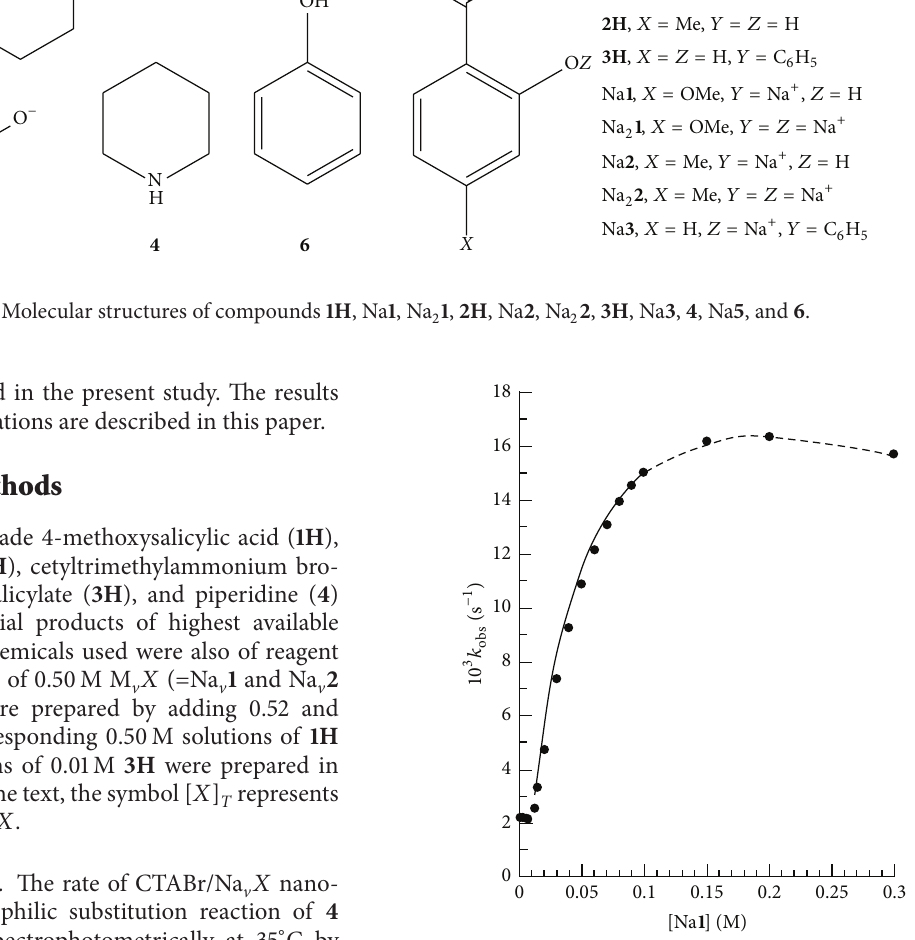
Figure 2: Plots showing the dependence of 𝑘 upon [Na 1 ] for obs piperidinolysis of 3H at 0.2 mM 3H , 0.1 M 4 , 0.03 M NaOH, and 35 ∘ C.Thesolidlineisdrawnthroughthecalculateddatapointsusing and 𝐾 𝑋/𝑆 ), listed in Table 2. The (2) with kinetic parameters ( 𝑘 cat dotted line is drawn through the predicted data points assuming the presence of WM at [ Na 1 ] op 0 < [Na 1 ] ≤ 300